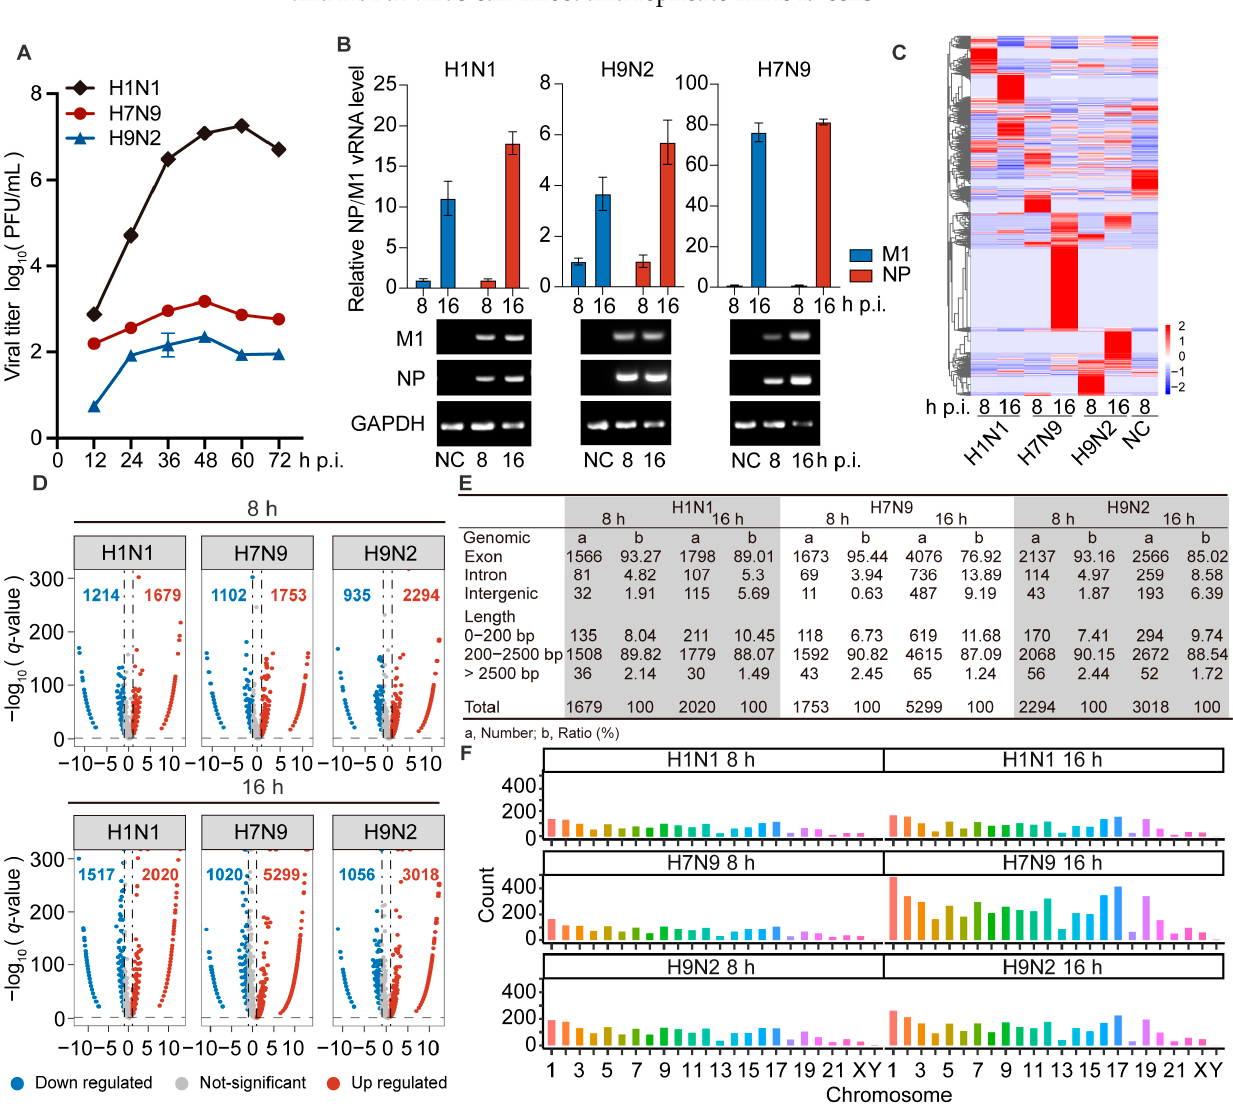
Figure 1. The circRNAs of A549 cells infected with H1N1/H7N9/H9N2 subtype IAV, and uninfected cells were analyzed by RNA-Seq. ( A ) Growth curves of H1N1/H7N9/H9N2 subtype IAV in A549 cells infected at an MOI of 0.001 for 72 h. The virus titer was monitored by plaque formation at